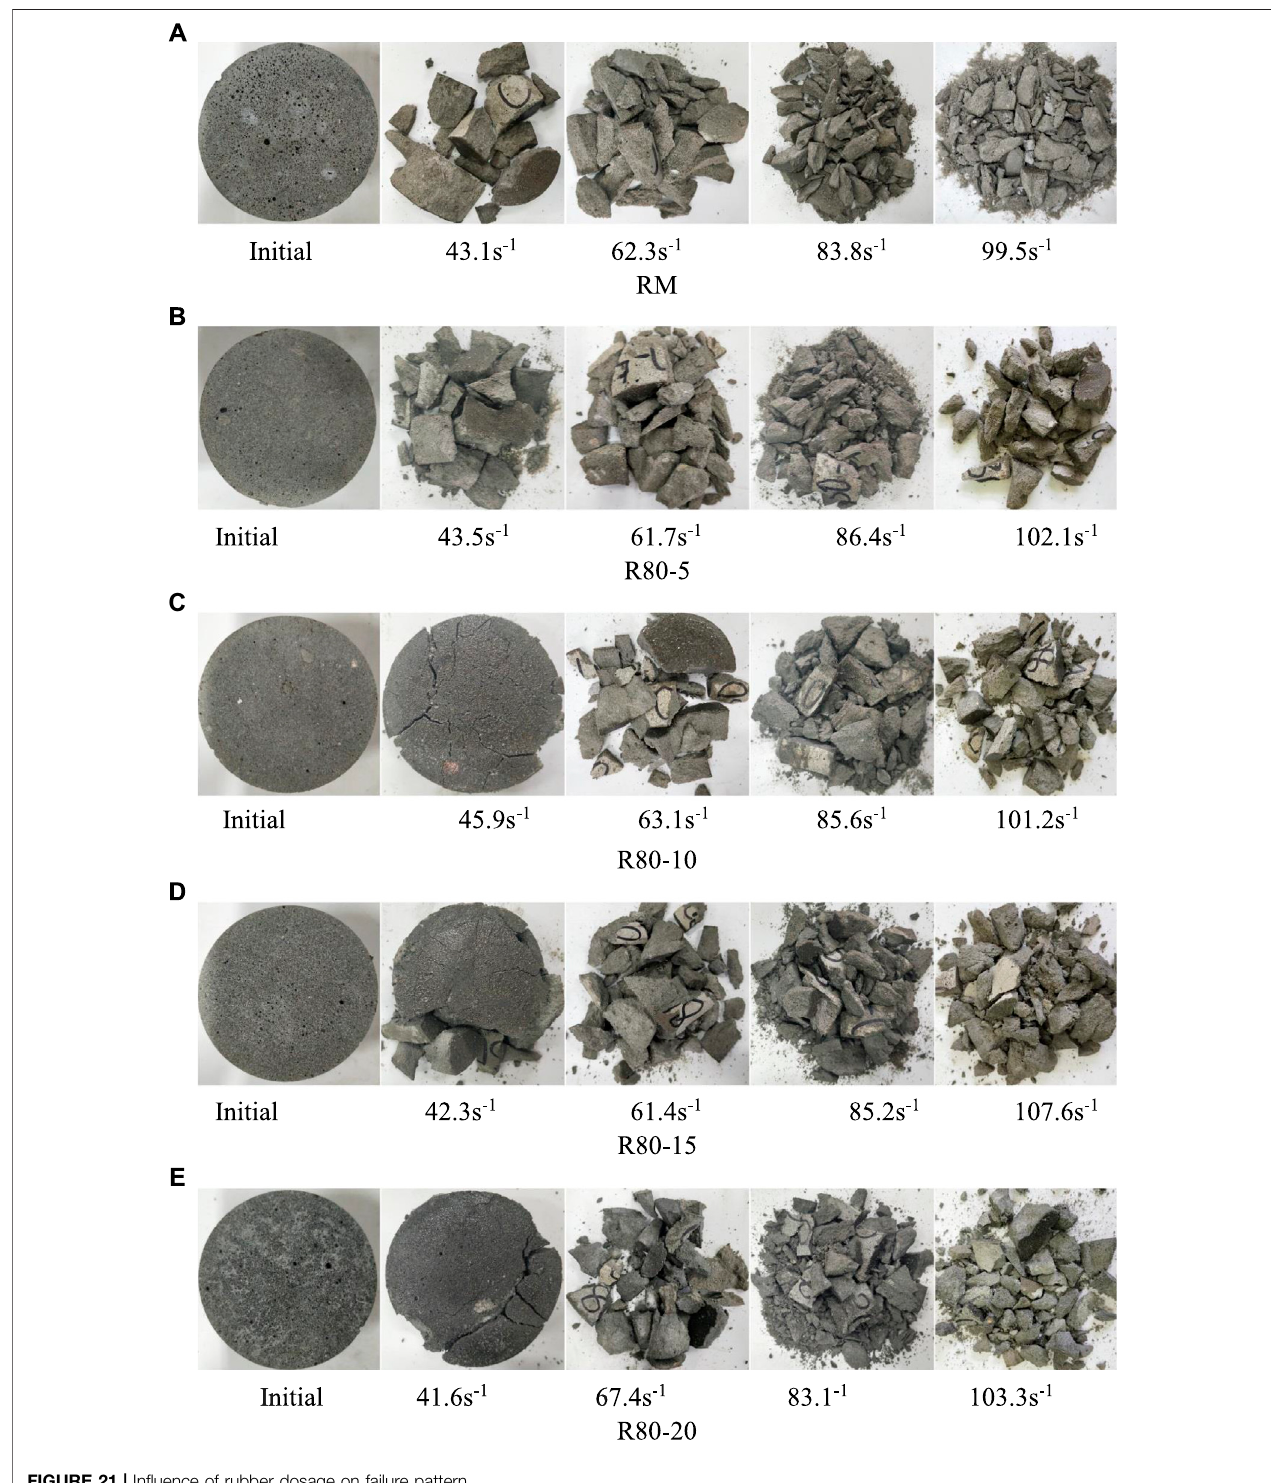
FIGURE 21 | In fl uence of rubber dosage on failure